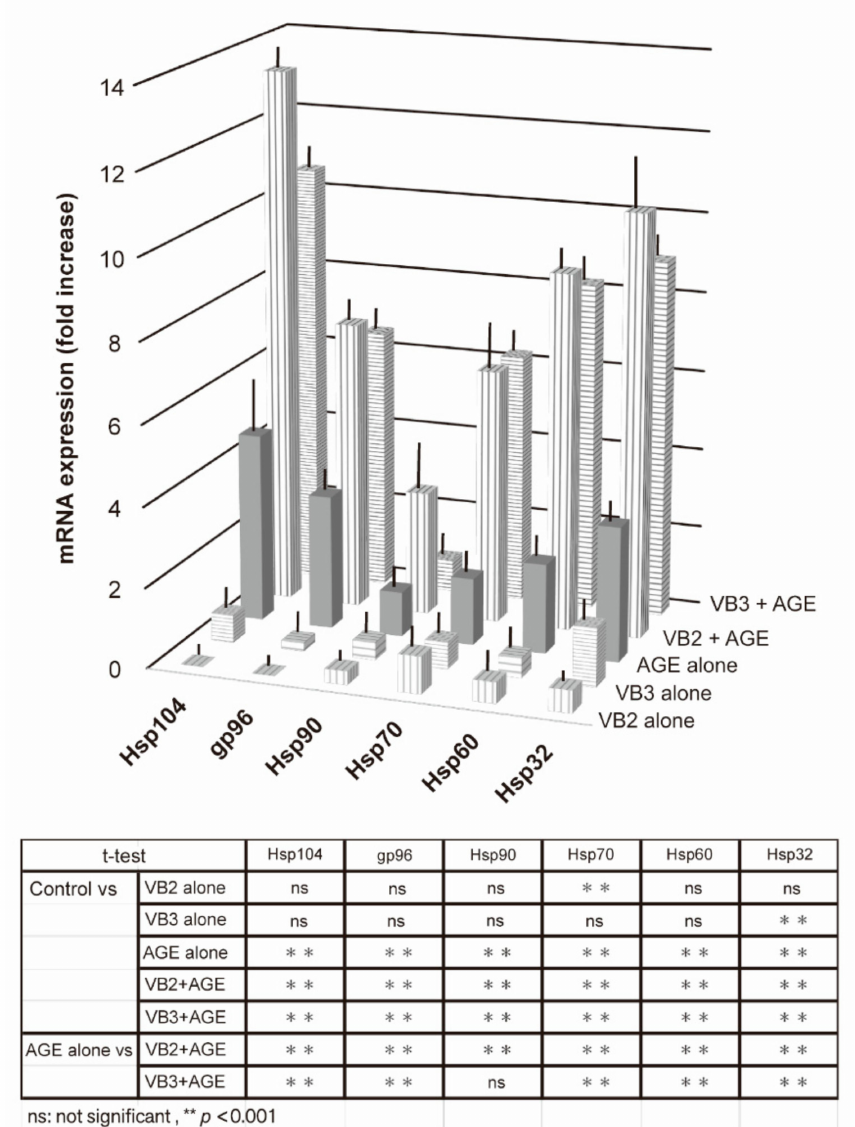
Figure 3. Effects of VBs on the mRNA expression of several heat shock proteins (Hsps) in NHDF treated with AGE. NHDF were incubated with 10 µ g/mL of VB2 or VB3 in the presence or absence of 100 µ g/mL AGE. Four hours after the incubation, the mRNA expression levels of Hsps were measured using qRT-PCR. The effects of VBs on Hsp mRNA expression levels were examined for significant differences from the untreated group. The effects of VBs on the mRNA expression of Hsps under AGE-induced stress conditions were analyzed in comparison with the response of AGE-treated cells alone. ** p <